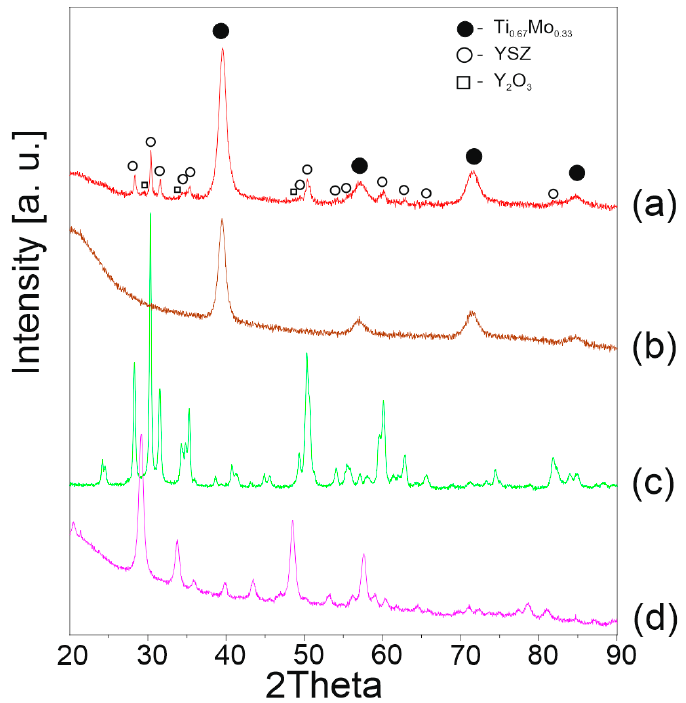
Figure 3. XRD patterns of 35–10 composite powder after mixing with YSZ—before sintering ( a ), and after MA ( b ) with additionally revealed YSZ ( c ) and Y 2 O 3 powder ( d ).